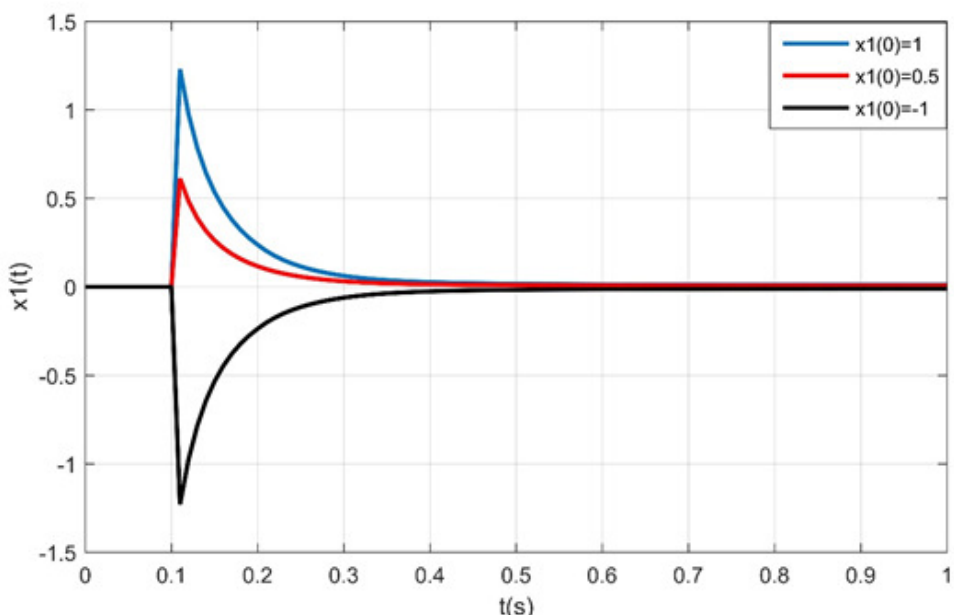
Figure 3. The behaviors of uniformly, asymptotically and Mittag–Leffler stable solution x 1 ( t ) of the system of of FrRIDEs in Equation (11) for q = 0.9, τ = 1 t ≥ 1 . 10